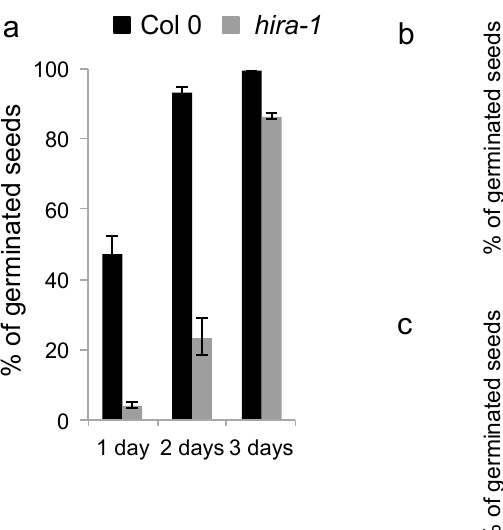
Figure 4. Enhanced seed dormancy of hira-1 mutants is not alleviated upon treatment with ABA, GA or ethylene. Germi- nation of Col-0 (black, square) and hira-1 mutant (dark grey, circle) seeds in presence (filled line) or absence (dashed line) of ABA (1 µM) ( a ) at 10 °C in darkness or of GA (1 mM) ( b ) and ethylene (50 ppm) ( c ) at 25 °C in darkness. Means of